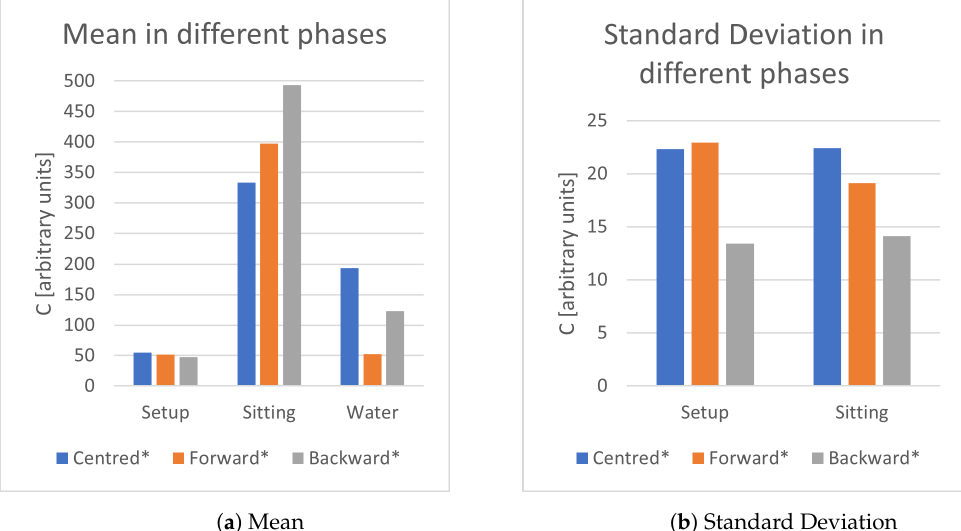
Figure 5. Study of different positioning of sensing plates. * Auto-calibration occurred during water